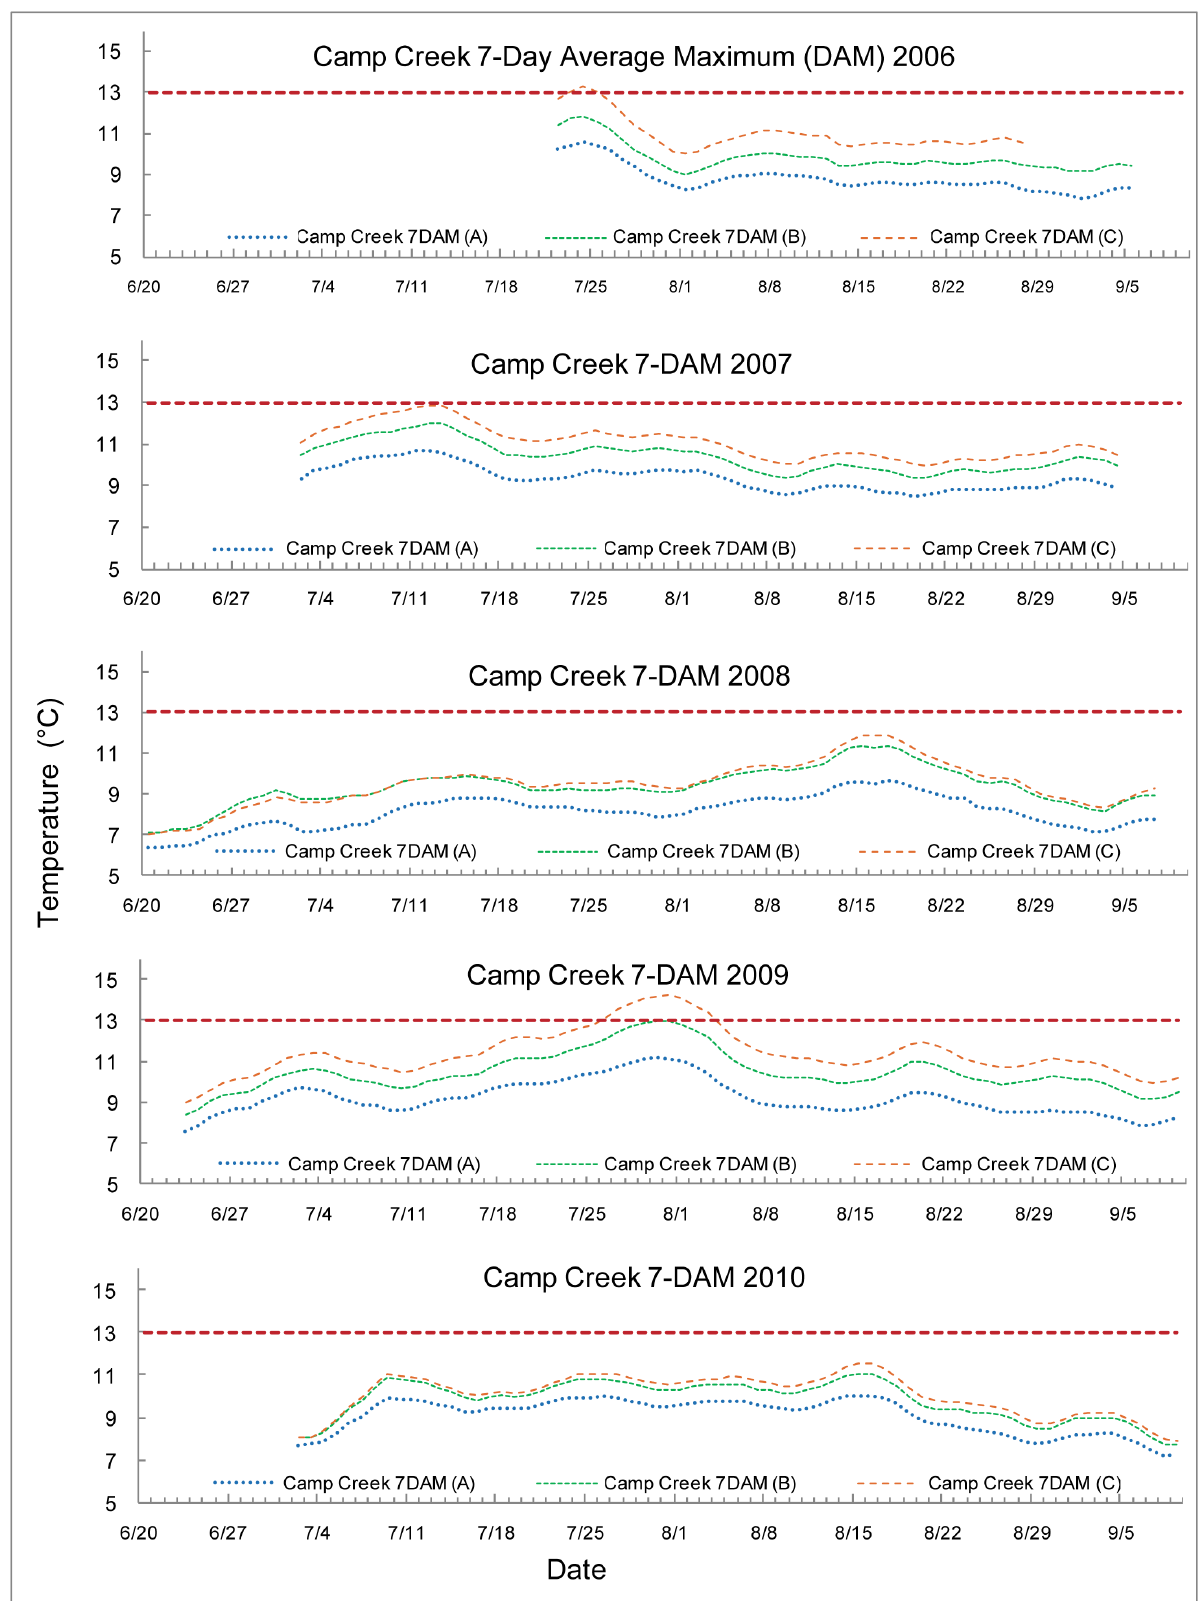
Figure 4. 7-Day average maximum (7-DAM) temperatures of Camp Creek.